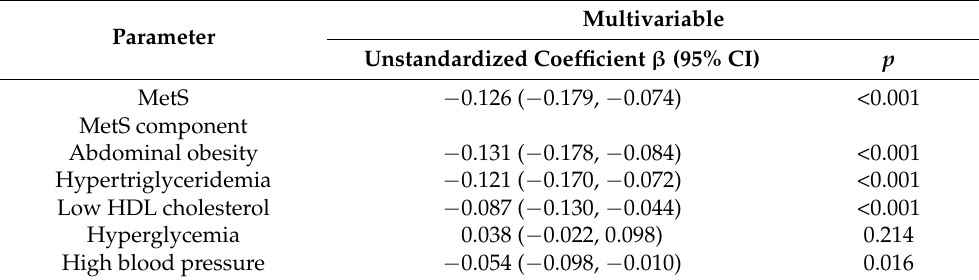
Table 2. Association between MetS and its components with baseline BMD T-score using multivari- able linear regression analysis in all participants.